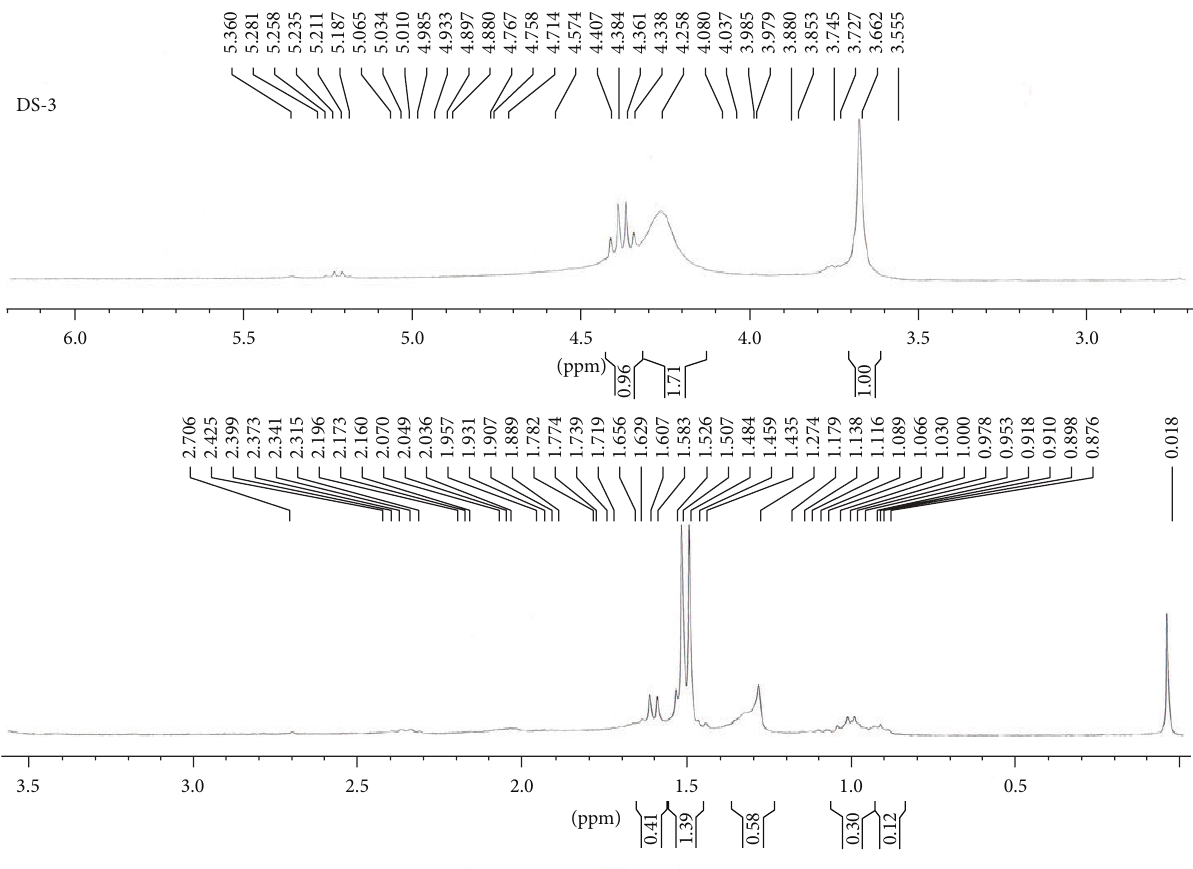
Figure 4: 1H NMR spectrum of biosurfactant produced by Lactobacillus casei MRTL3.